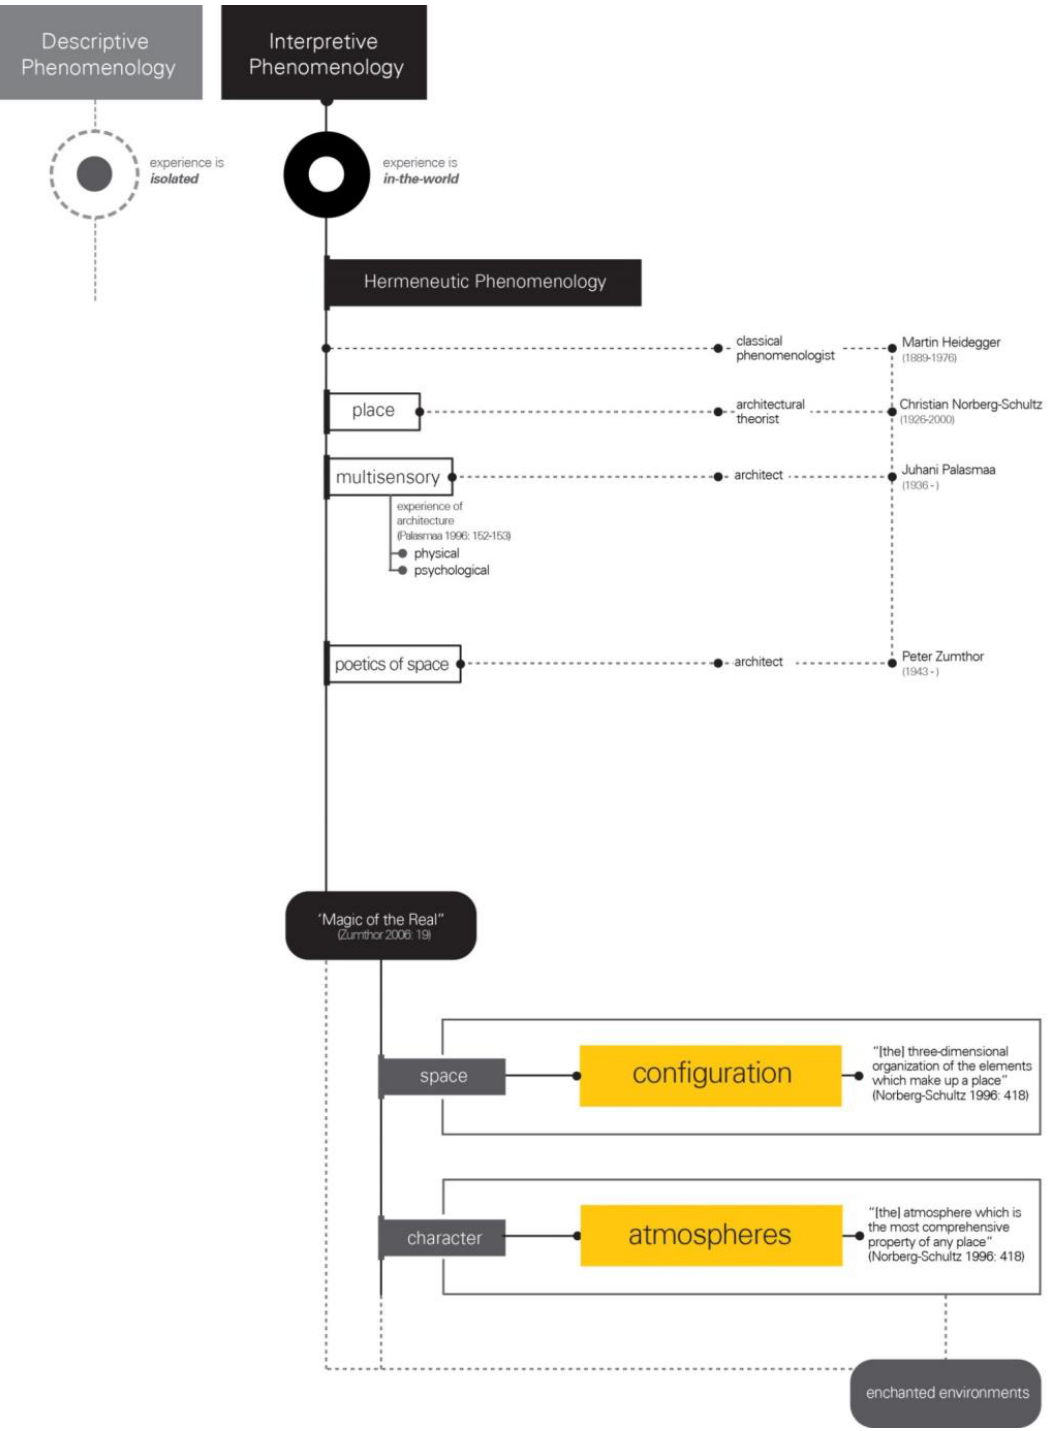
Figure 1. Diagrammatic exploration of the Theoretical Framework guiding the investigation (Author,